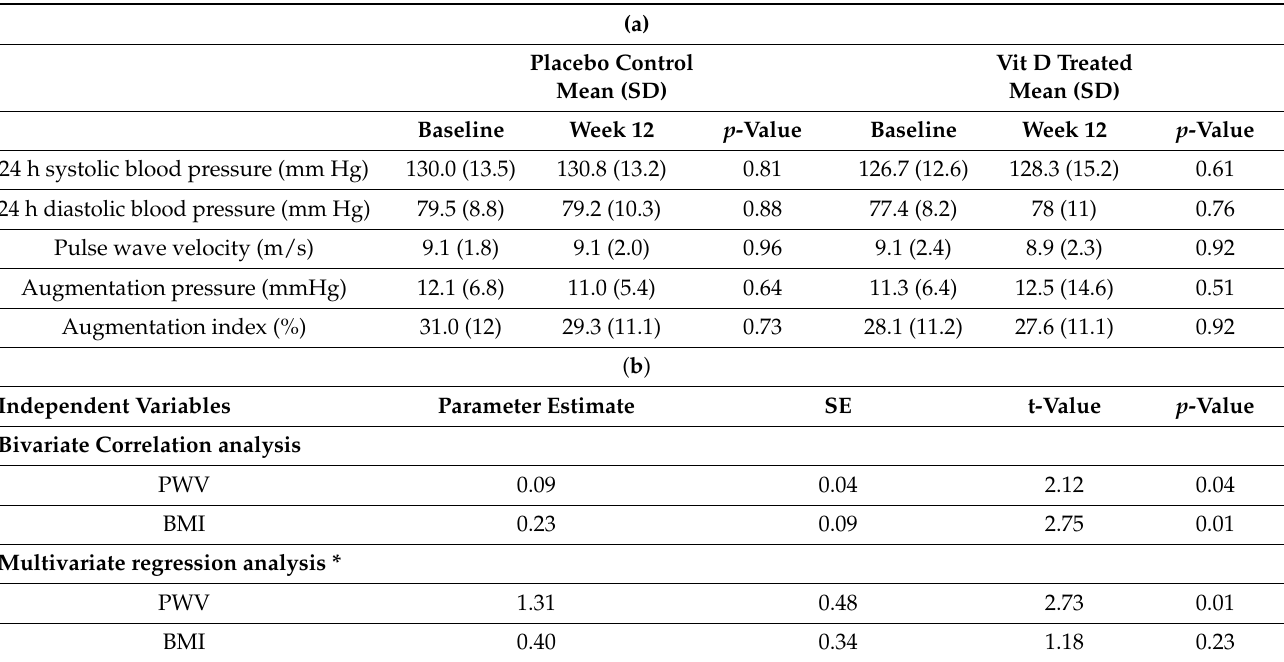
FGF-23: c-terminal fibroblast growth factor-23; PAI-1: plasminogen activator inhibitor-1; flOPN: full length osteo- pontin; CKD-EPI eGFR: Chronic Kidney Disease-Epidemiology Collaboration equation to estimate glomerular filtrate rate; PTH: parathyroid hormone. * Multivariate regression analysis controlling for waist circumference, systolic and diastolic blood pressure, augmentation pressure, augmentation index, eGFR, protein to creatinine ratio, intact PTH, and serum calcium. PWV: pulse wave velocity; BMI: body mass index.